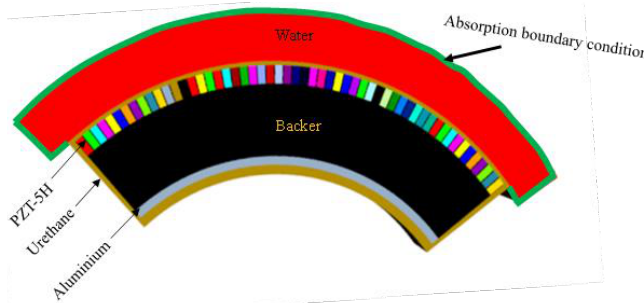
Figure 7. The cross-section of the FEA model of the 5 × 55 conformal array.